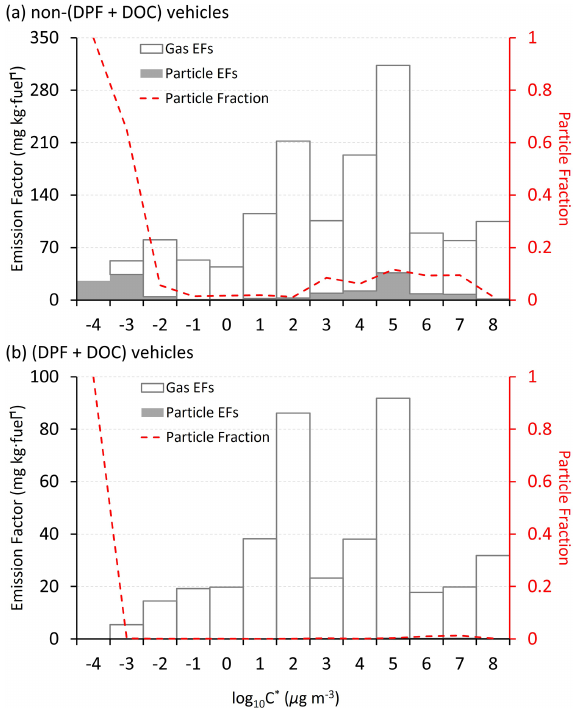
Figure 7. The EFs of gaseous and particulate I/SVOCs (the respec- tive hollow and filled stack columns) and the particle mass frac- tion (red dashed line) in each volatility bin computed for (a) non- (DPF + DOC) vehicles and (b) (DPF + DOC)